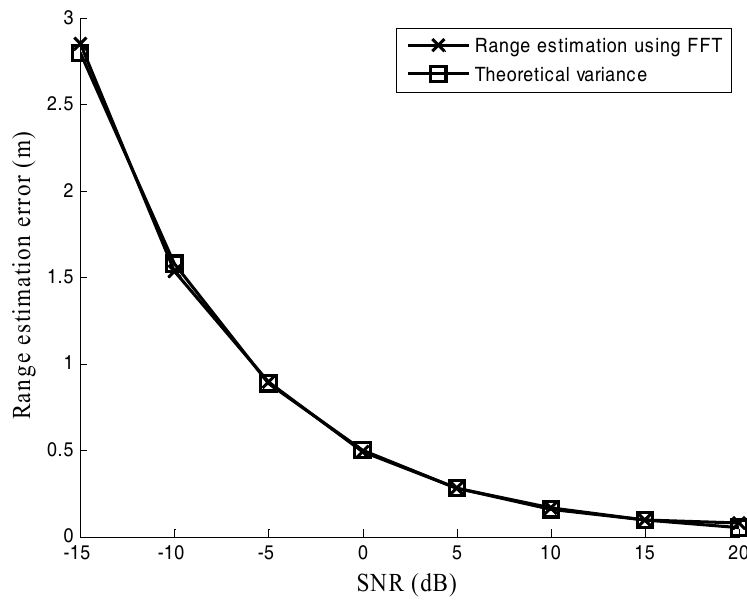
Figure 3. Range estimation error under different signal noise ratio (SNR).